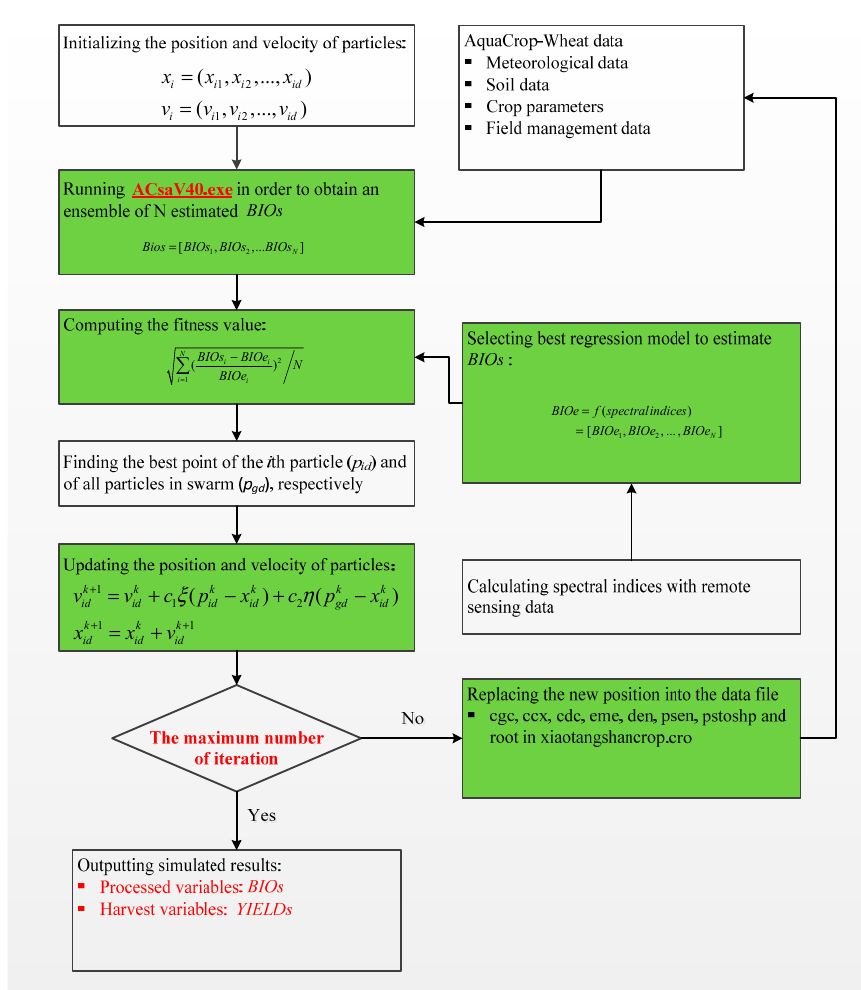
Figure 1. Flowchart of the Particle Swarm Optimization (PSO) assimilation method for the AquaCrop model and remote sensing data.